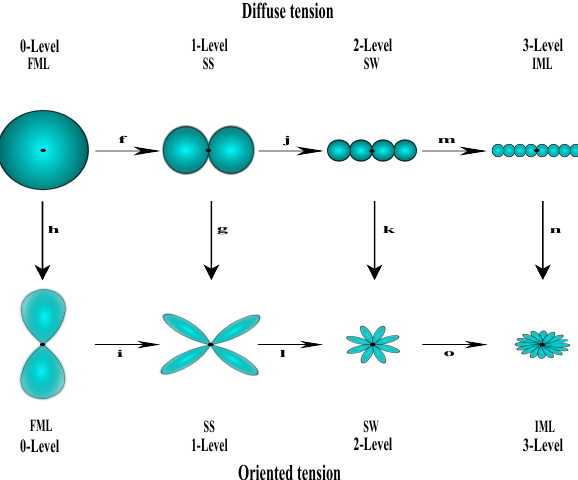
Figure 15. DT and